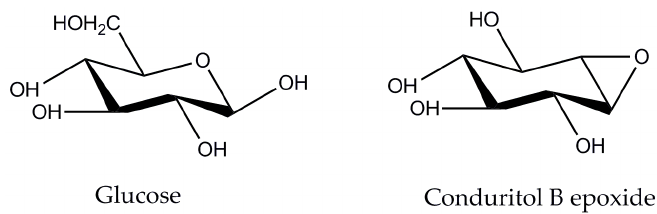
Figure 1. Structures of glucose and conduritol-B-epoxide, two potent inhibitors of enzymes with cellobiohydrolase activity.